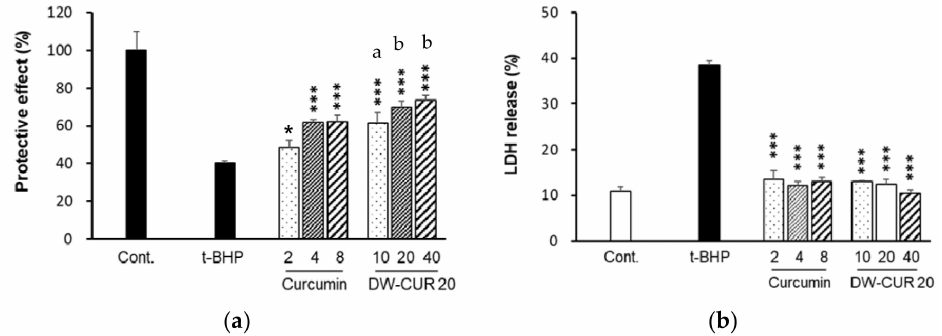
Figure 5. Protective e ff ect of DW-CUR 20 against t-BHP-induced cell death in HepG2 cells. Cells were pretreated with the indicated concentrations of DW-CUR 20 (10, 20, and 40 µ g / mL) or curcumin (2, 4, and 8 µ g / mL) for 6 h in FBS-free medium, followed by addition of t-BHP (final concentration 1 mM). After 6 h, cells were washed twice with PBS then analyzed for cell viability using EZ-CYTOX cell viability kit ( a ). Cells were pretreated with the indicated concentrations (10, 20, and 40 µ g / mL) of DW-CUR 20 for 6 h in FBS-free medium, followed by addition of t-BHP (final concentration 1000 µ M). After 90 min, supernatants were collected for LDH analysis. LDH was analyzed using CytoTox96 non-radioactive cytotoxicity assay kit and calculated according to manufacturer’s protocol ( b ). Data are presented as the mean ± SD of three independent experiments. * p < 0.05, *** p < 0.001 vs. the t-BHP group. a p < 0.05, b p < 0.01 vs. the corresponding curcumin